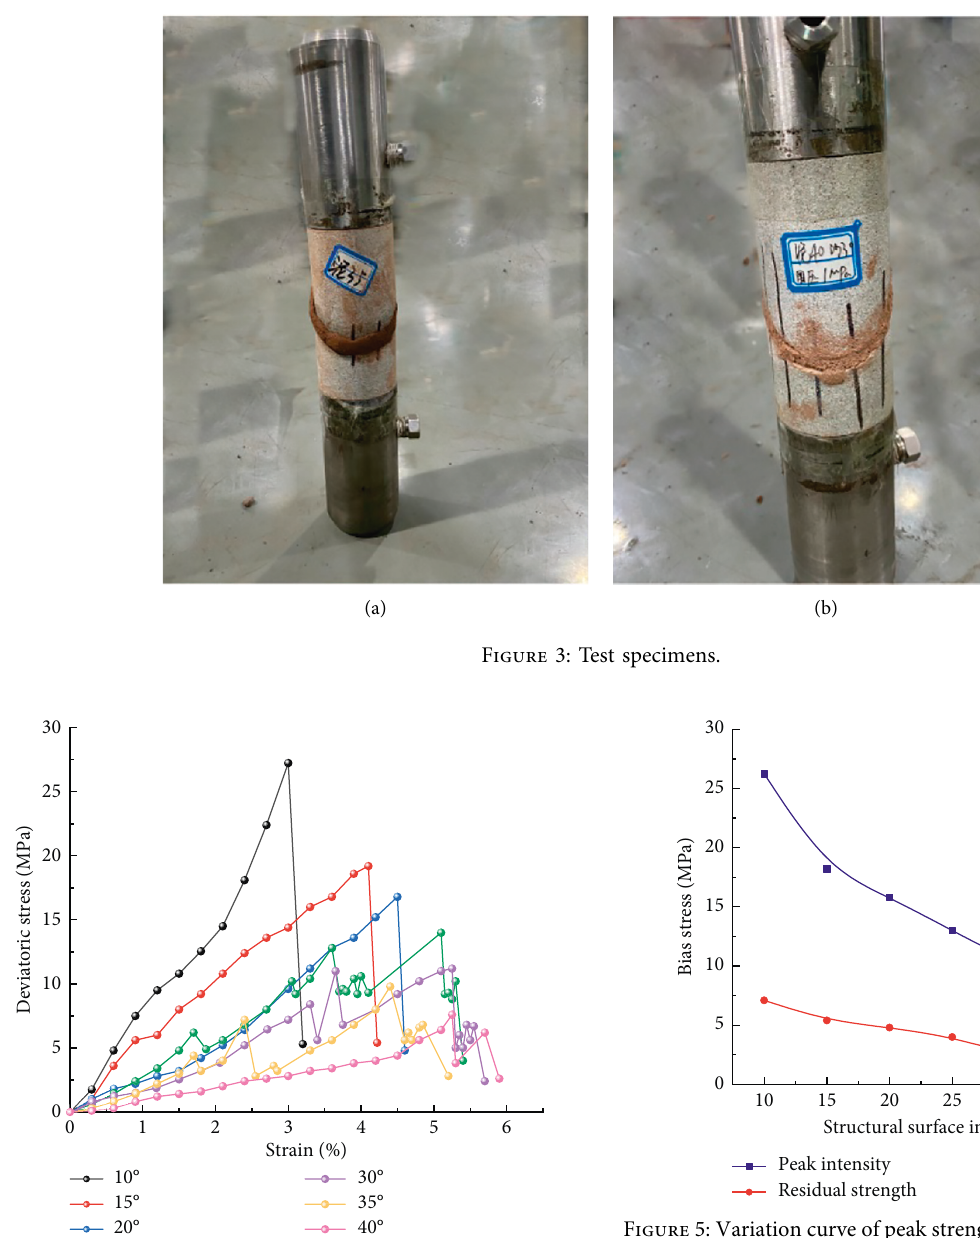
Figure 5: Variation curve of peak strength and residual strength of specimen with joint plane